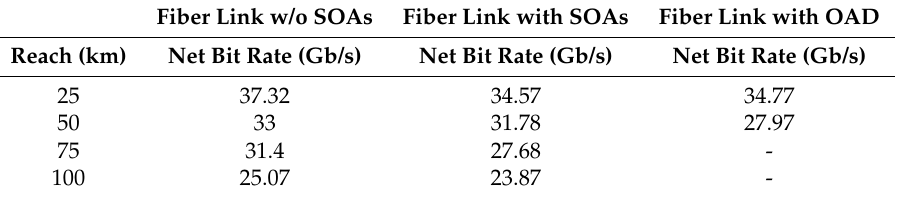
Table 1. Achievable net bit rate and maximum OSNR for different transmission distances using RA BL/PL algorithm, for different fiber link with and without SOAs and considering SOA-based OAD. Fiber Link w/o SOAs Fiber Link with SOAs Fiber Link with OAD Reach (km)